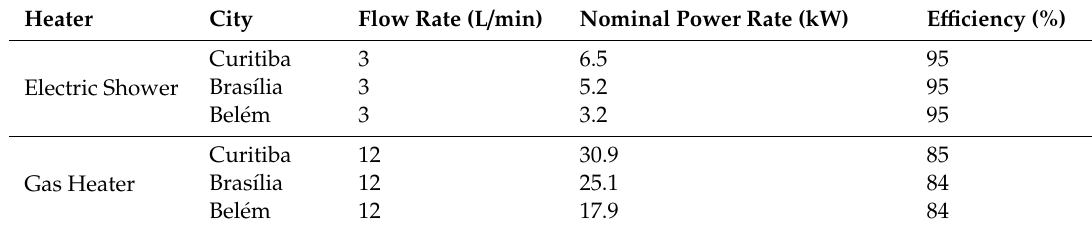
Table 1. Characteristics of each instantaneous